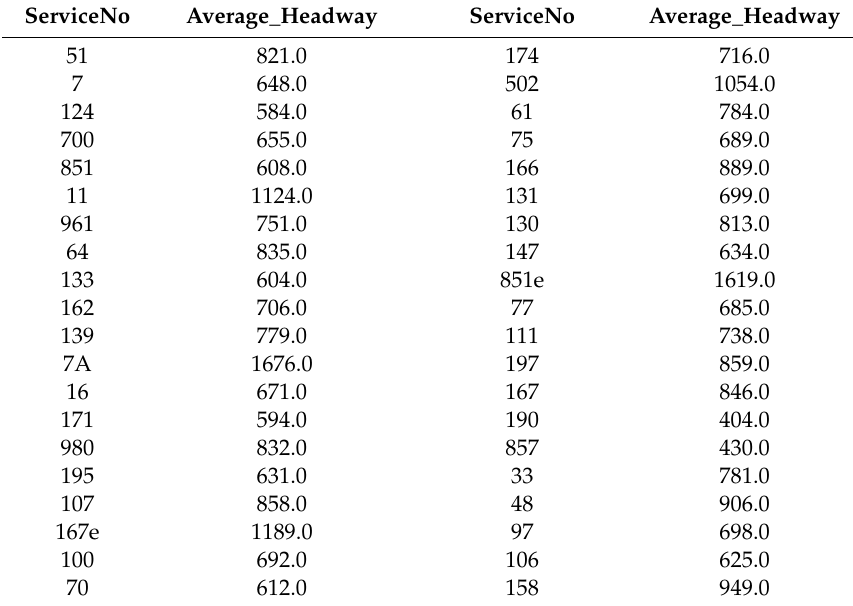
Table 4. Average bus service headway output generated using Spark SQL.